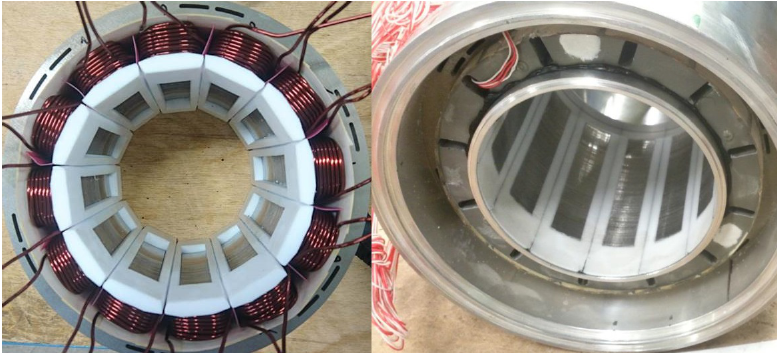
Figure 6. Wound stator before (left) and after (right) potting. The white plastics in the left picture are the bobbins used to pre-form the coils outside the machine. The excess material in the airgap is removed before potting and therefore not seen in right